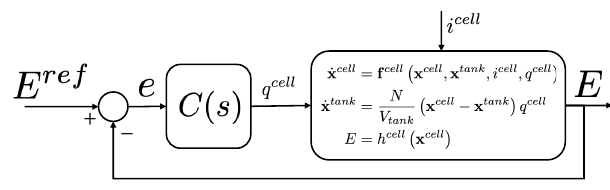
Figure 22. Closed-loop nonlinear simulation block